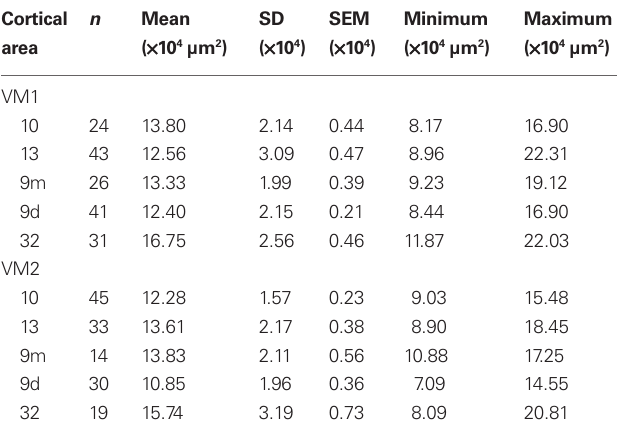
= 4.23) and VM2 ( F = 7.53). (1,4) (1,4)